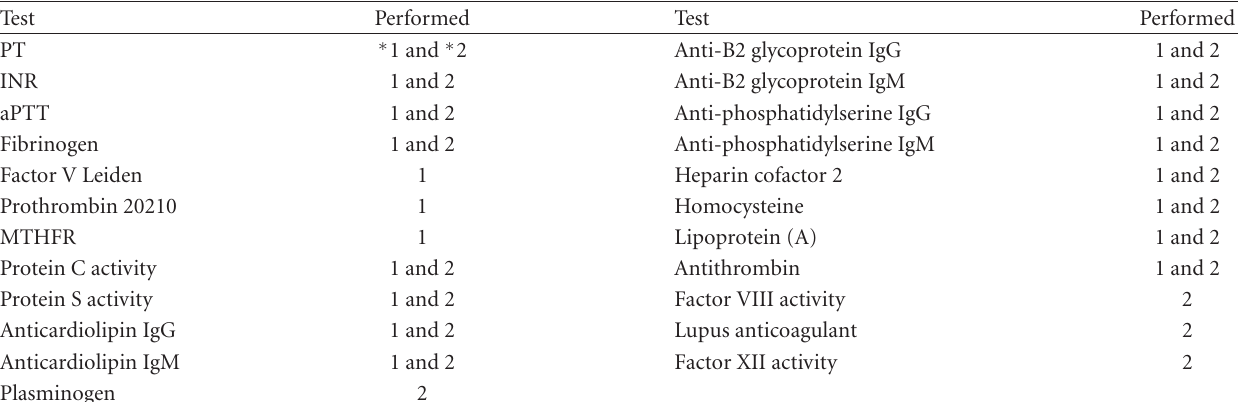
Table 1: Thrombophilia Evaluation Performed [10, 11].